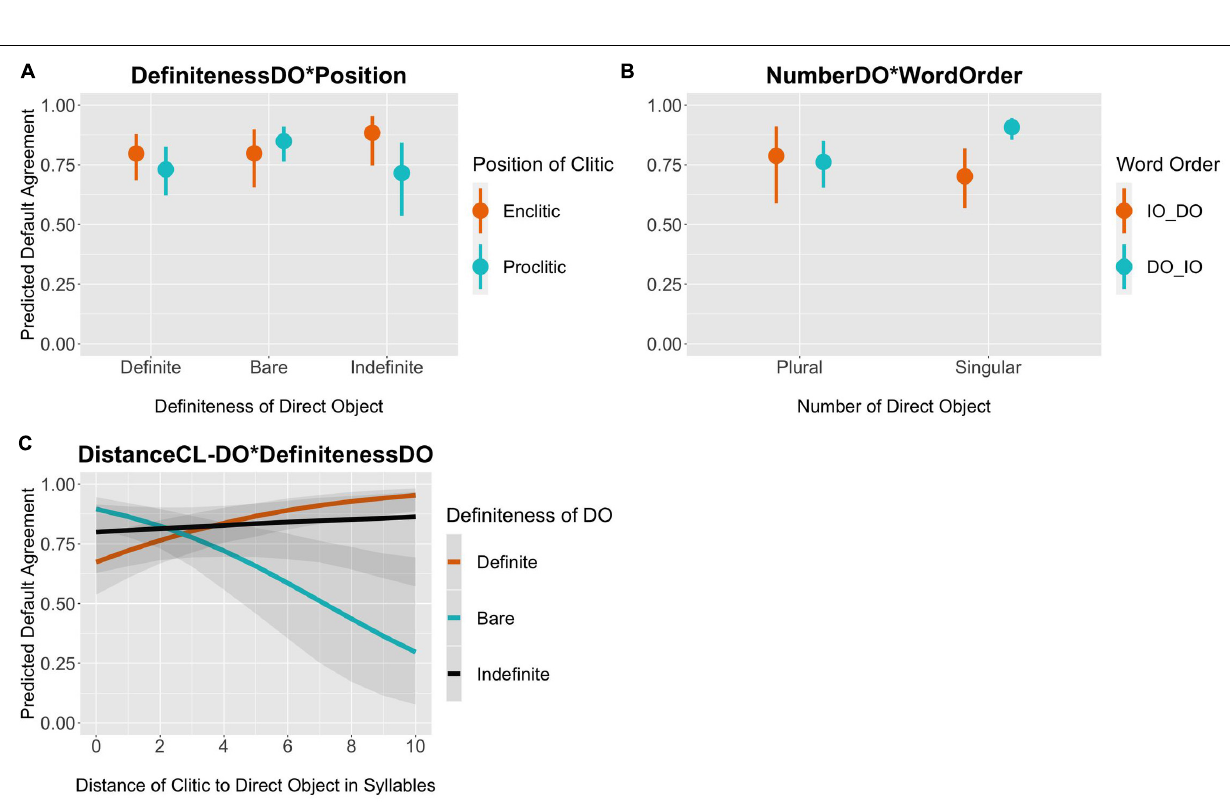
Frontiers in Psychology |